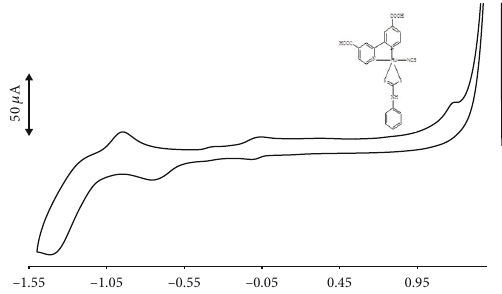
Figure 3: Cyclic voltammogram of FC